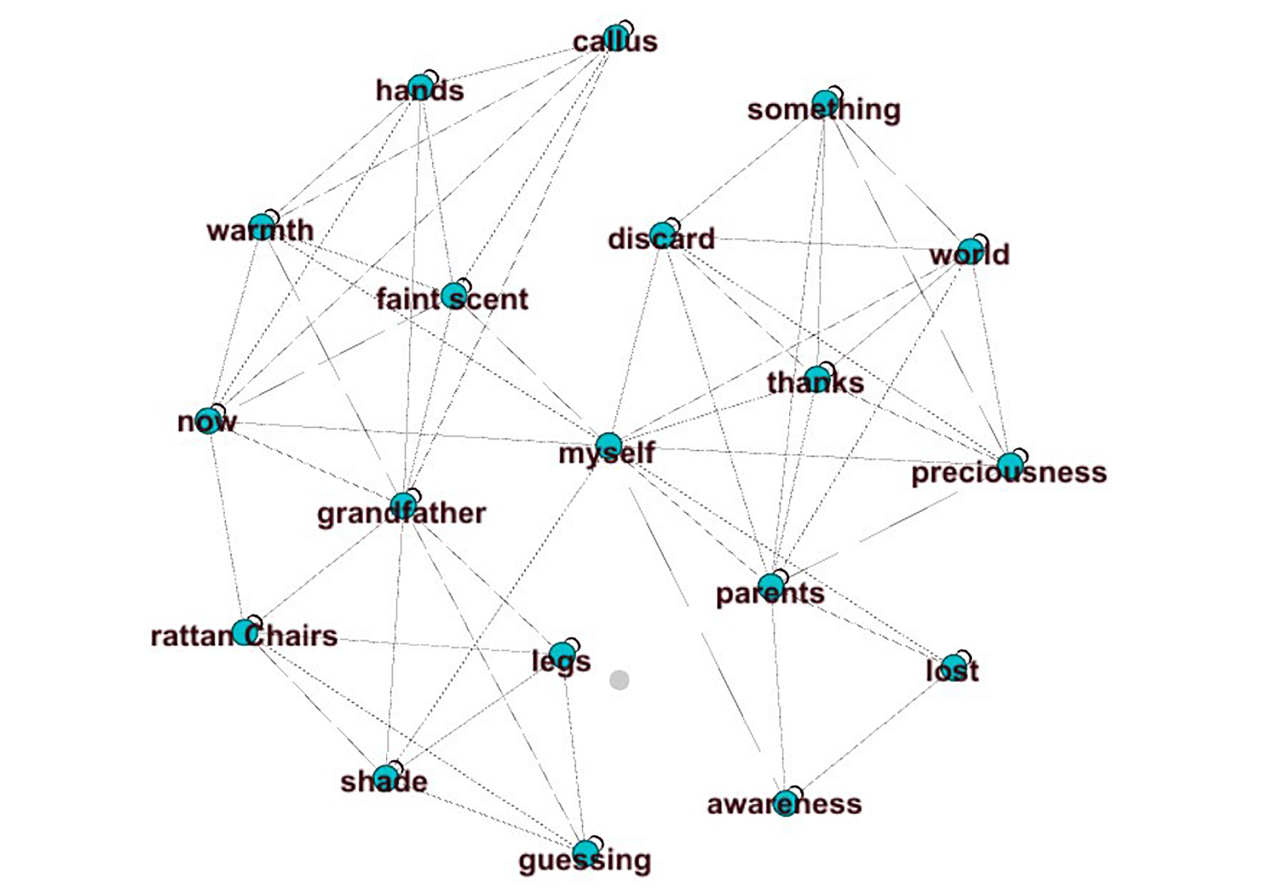
FIGURE 3 | Low-level main